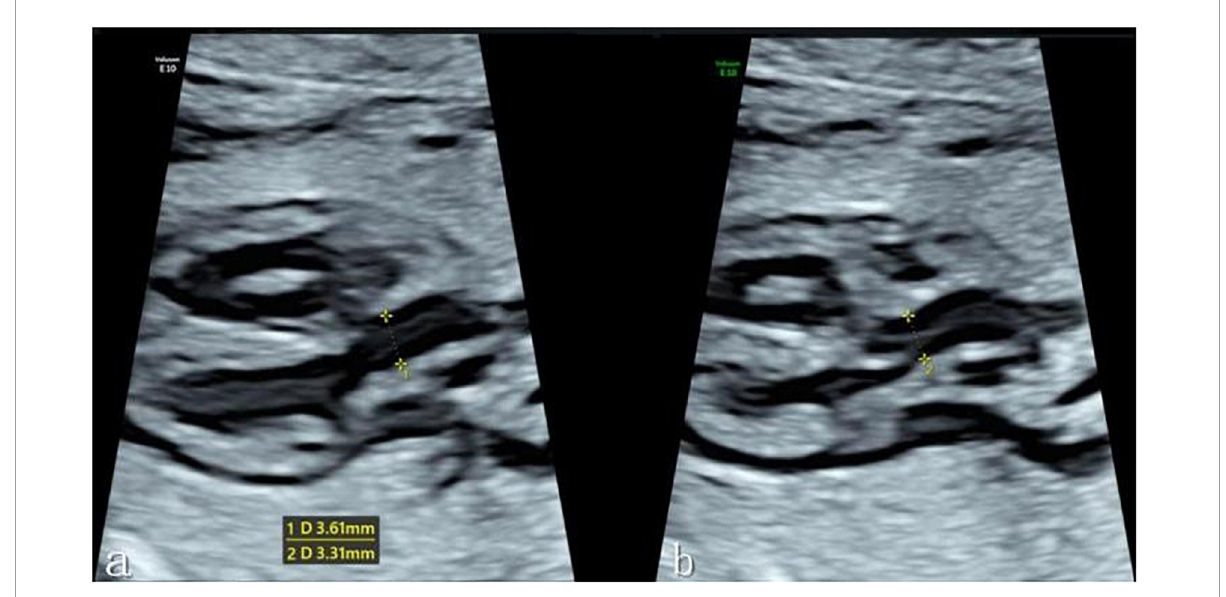
FIGURE1 (a) Measurement of the Dmax of the ascending aortic sinotubular junction at the end of systole in the left ventricular outflow tract view. (b) Measurement of the Dmin of the ascending aortic sinotubular junction at the end of diastole. *Caliper.